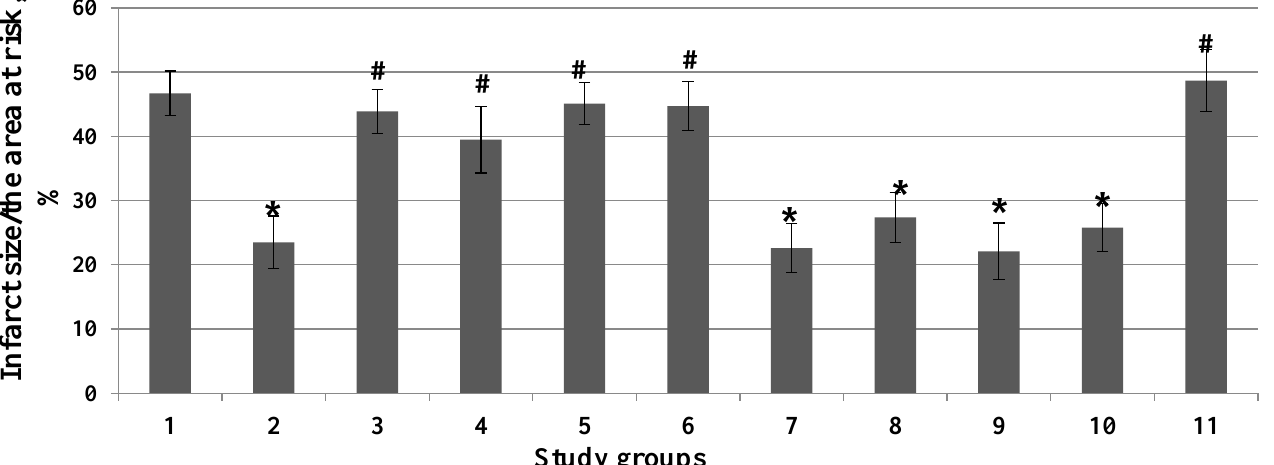
Figure 2. Involvement of opioid receptors in the mechanism of the infarct-limiting effect of deltorphin II ( Y -axis). Data represent the means ± SEM. * p < 0.05 vs. the control group; # p < 0.05 vs. the deltorphin II group. Each study group included 12 rats.